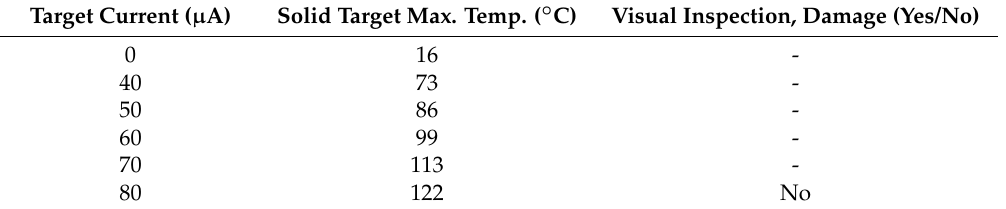
Table 2. Maximum recorded temperature and visual inspections at 80 µA.